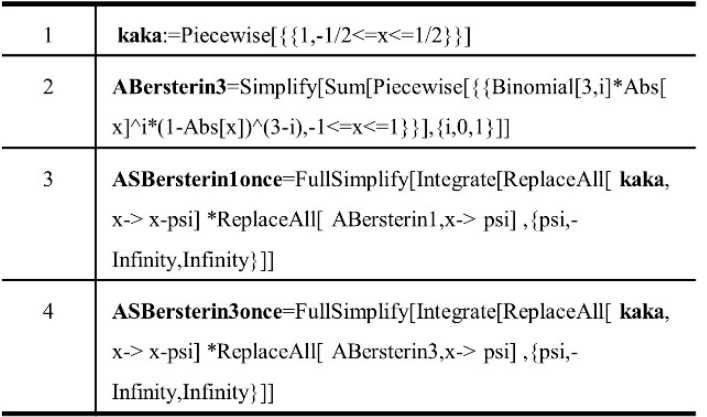
Figure 3. Mathematica script demo for deriving aggregated-smoothed Bernstein shape functions.